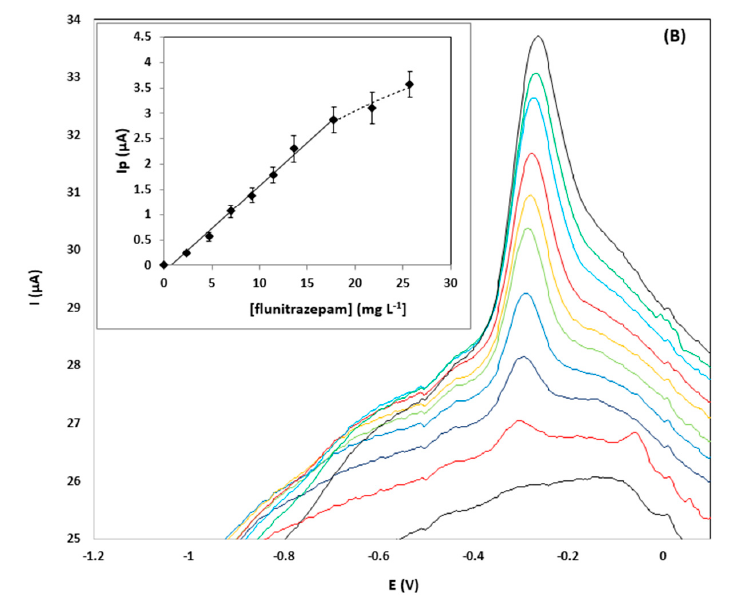
Figure 3. CVs for the determination of 0–25.7 µg L − 1 of flunitrazepam in a pooled gin sample diluted 1:1 ( v / v ) using the drop-volume detection format using: ( A ) the reduction peak R 2, and; ( B ) the oxidation peak O 1 .